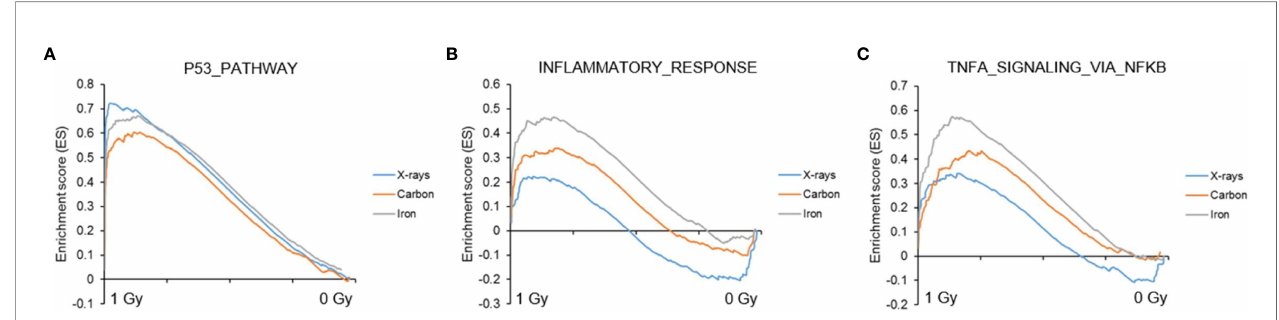
FIGURE 5 | GSEA analysis. GSEA enrichment plots for three gene sets following exposure to X-rays, carbon or iron ions: (A) p53 pathway, (B) In fl ammatory response, (C) TNF a signaling via NF- k B. Gene sets with a distinct peak at the beginning or the end of the ranked list are generally the most relevant, indicating that this speci fi c gene set is enriched in up- or down-regulated genes,